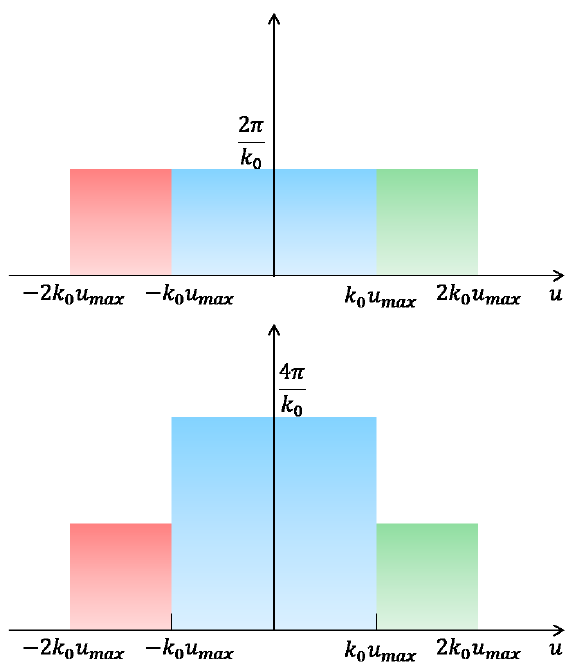
Figure 2: The case of three angles of incidence Ω i = {− u max , 0 , u max } . The top panel gives a pictorial view of the frequency bands which now overlap. The bottom panel shows how the spectrum of the kernel can be still given in terms of disjoint